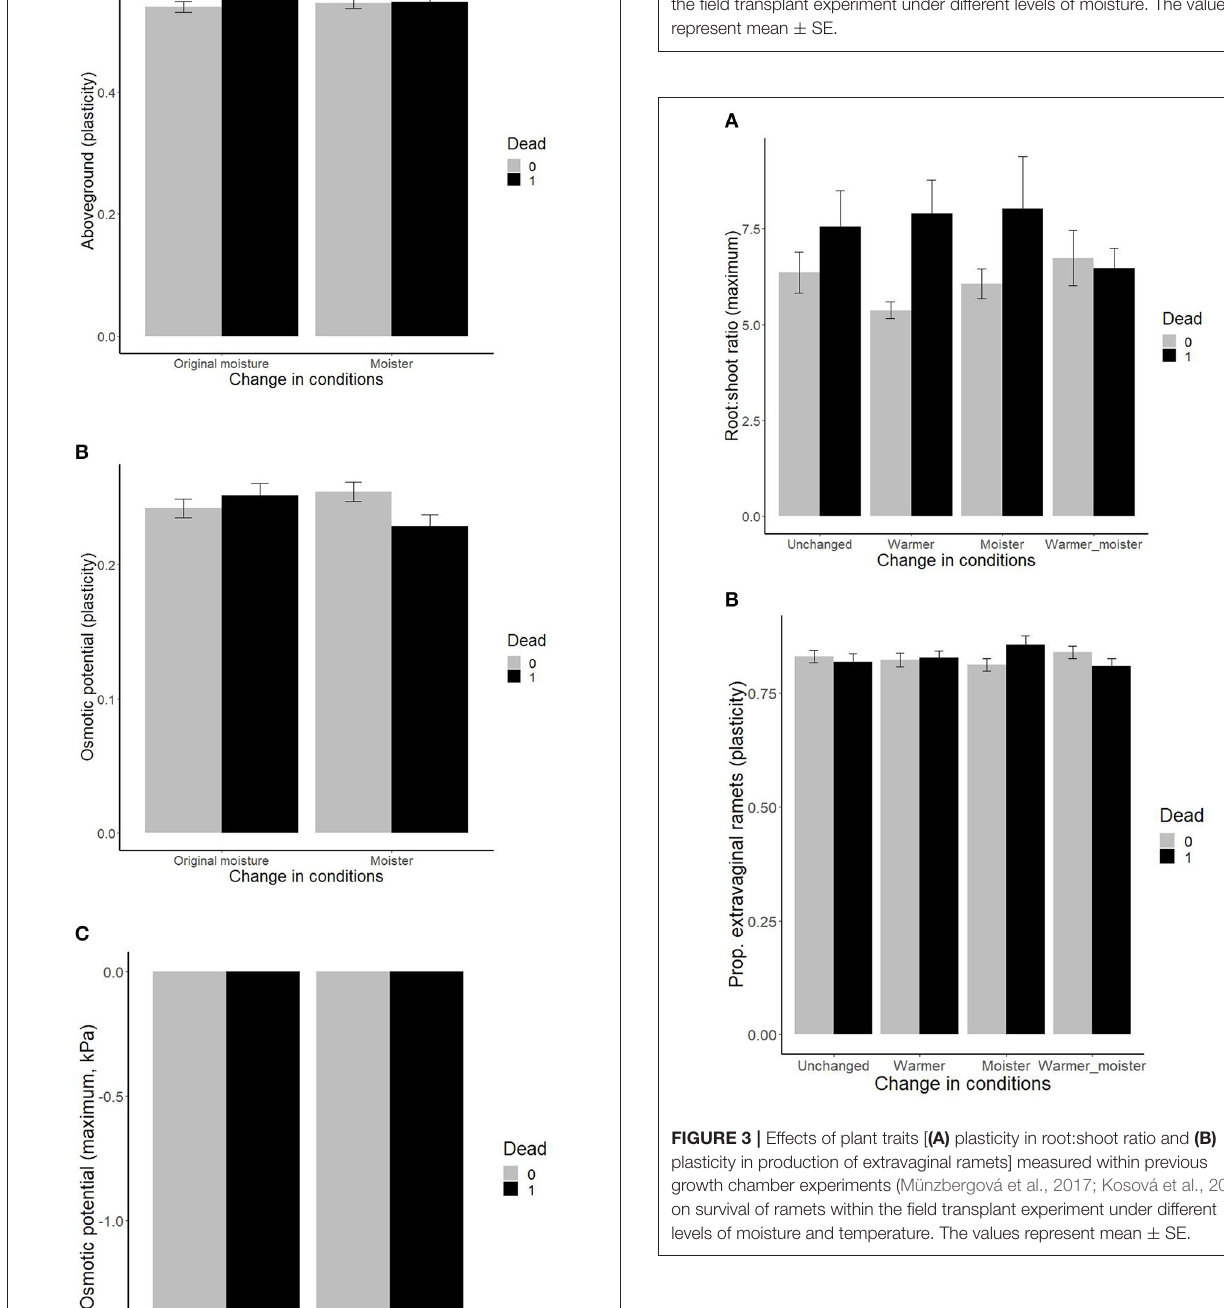
FIGURE 2 | measured within previous growth chamber experiments (Münzbergová et al., 2017; Kosová et al., 2020) on survival of ramets within the field transplant experiment under different levels of moisture. The values represent mean ± SE.